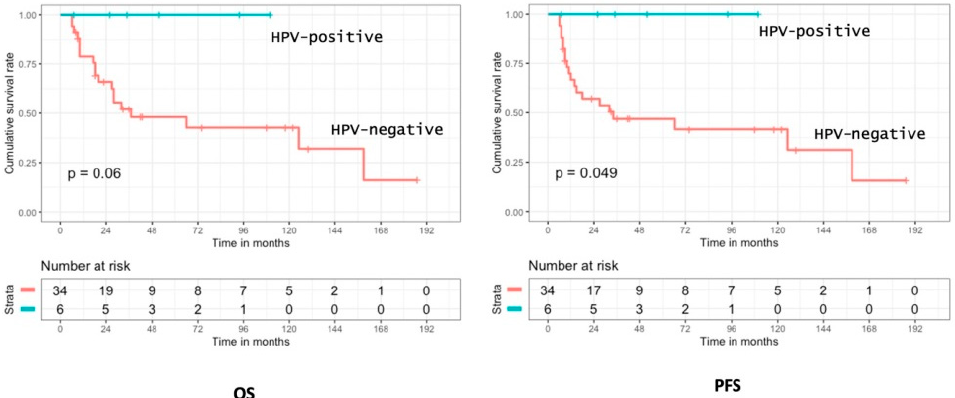
Figure 6. Overall survival and progression-free survival according to HPV status in SNSCC.